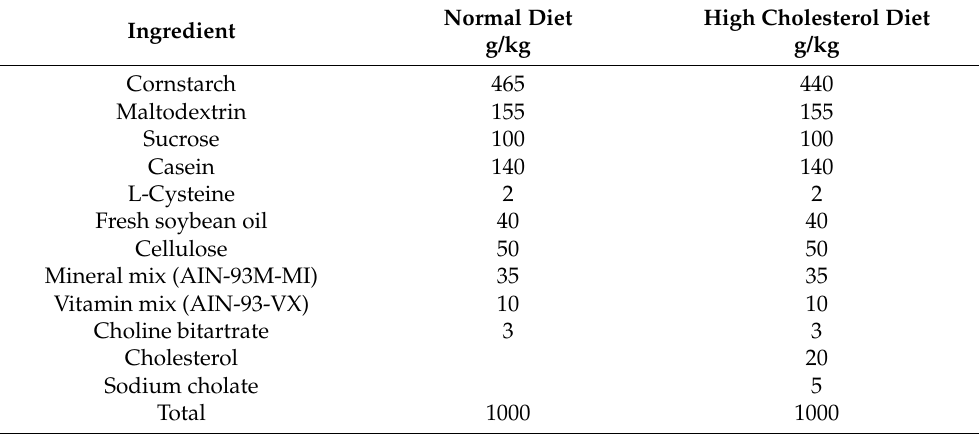
Table 1. Composition of the normal and high-cholesterol